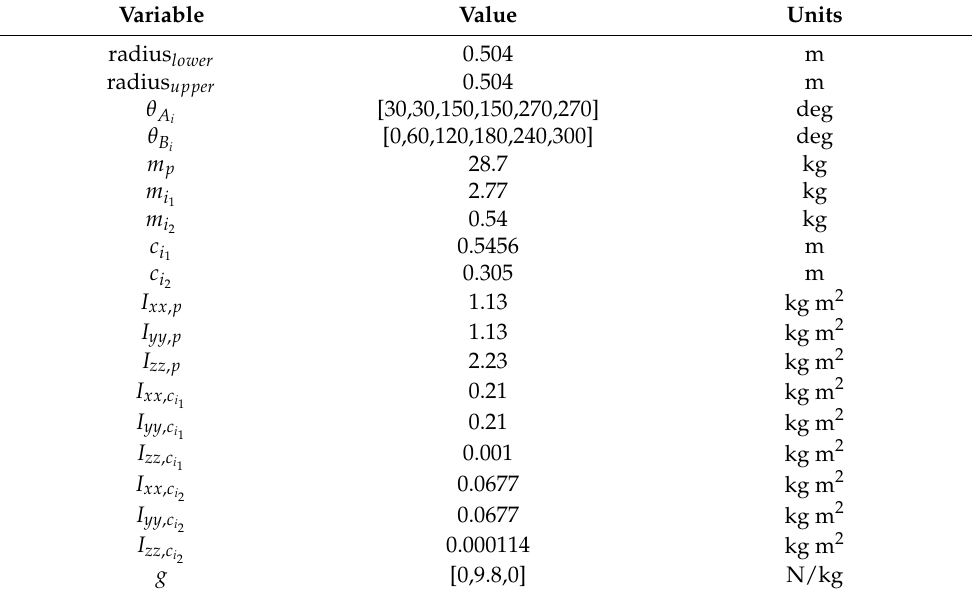
Table 1. Platform geometric and inertial